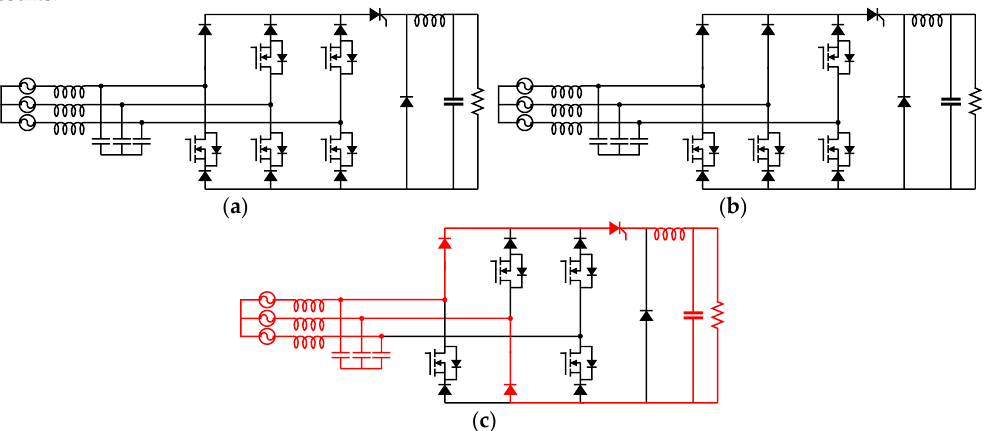
Figure 9. Fault cases when: ( a ) one switch is shorted, ( b ) two parallel switches are shorted, ( c ) two diagonal switches are shorted.